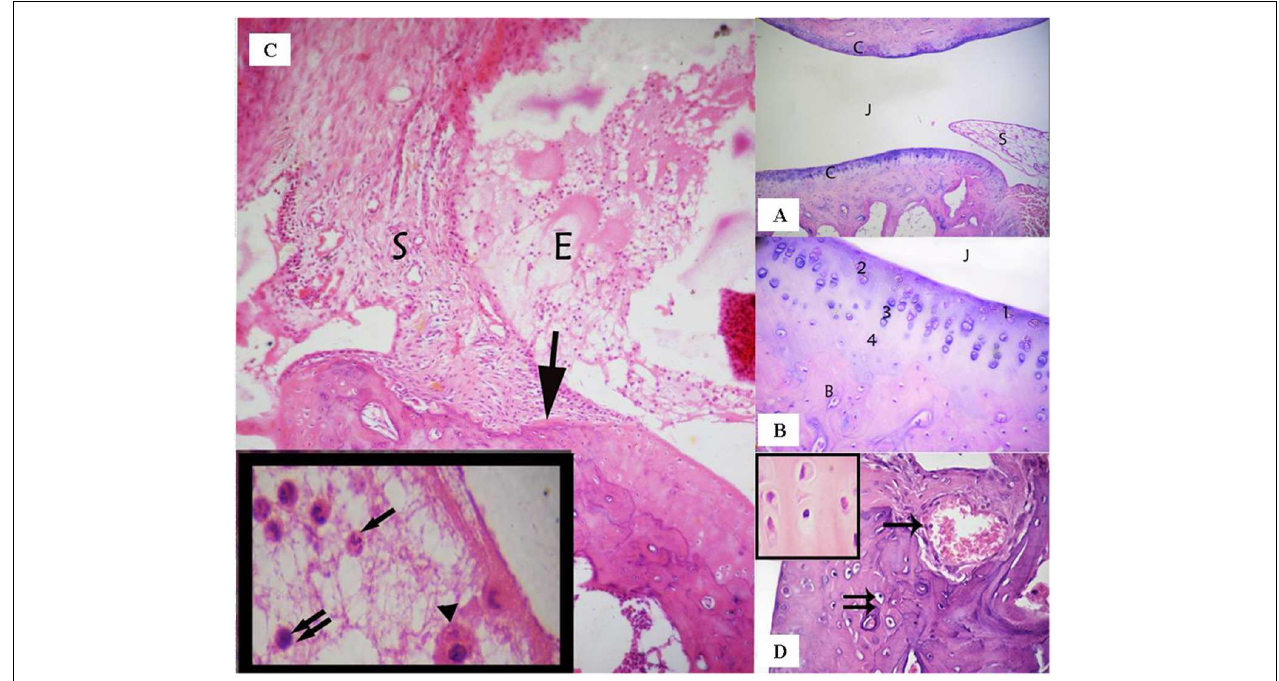
FIGURE 2 | (A) Ankle joint of the control group showing the articular cartilage (C) , the joint cavity (J), and the synovial membrane (S). (Control group, H & E, × 100). (B) Articular cartilage with its four zones: a superficial tangential zone (1), a transitional zone (2) that contained scattered chondrocytes, a radial zone (3) containing chondrocytes arranged perpendicular to the surface. A calcified zone (4) separating hyaline cartilage from the underlying subchondral bone (B) . (Control group, H & E, × 400). (C) A photomicrograph of the rheumatoid arthritis group showing infiltration of the synovial tissue (S) by inflammatory cells- that grows over the articular cartilage ( ↑ ) and causes its erosion and irregularity. The nearby articular cartilage has lost its basophilia. The joint cavity is filled with inflammatory cells and exudation (E). Inset: fluid filling the joint cavity contains fibrin deposits and many inflammatory cells, including polymorphonuclear leukocytes ( ↑ ), lymphocytes ( ↑↑ ), and macrophages ( (cid:78) ). (Arthritis group H & E, × 100, Inset × 1000). (D) A photomicrograph of arthritis group showing invasion of the cartilage matrix by fibrovascular synovial tissue that is compressing the underlying bone. Note: Blood vessels have invaded the cartilage matrix ( ↑ ). Notice also apoptotic chondrocytes ( ↑↑ ). Inset shows the acidophilic matrix of cartilaginous tissue and chondrocytes with darkened nuclei and shrunken cytoplasm; some chondrocytes have eccentric nuclei. (Arthritic group, H & E, × 400; Inset × 1000).